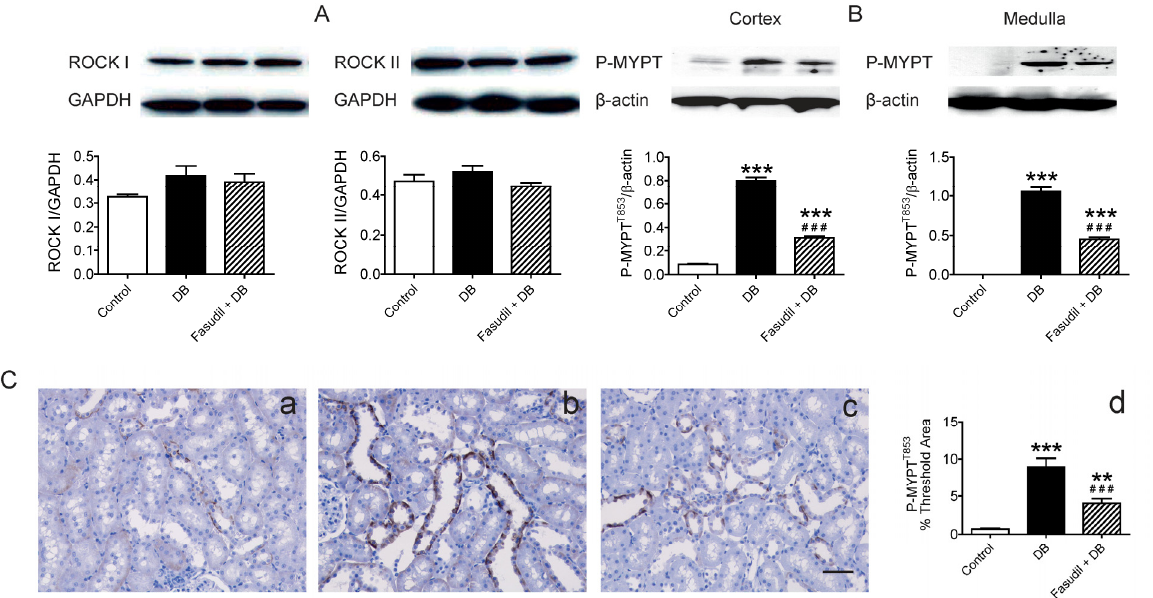
Figure 5. Effects of Rho kinase inhibition on Rho kinase expression and activity in kidney of diabetic rats. ( A ) Representative bands and analysis of protein levels of ROCK I and ROCK II in renal cortex of rats; ( B ) Representative bands and analysis of protein levels of phosphorylated form of MYPT1 (P-MYPT1) from the renal cortex and medulla; ( C ) Quantitative analysis and representative images of immunohistochemistry for P-MYPT1 from the renal cortex. a, control rats; b, diabetic rats; c, diabetic rats treated with fasudil; d, statistical analysis of immunohistochemistry for P-MYPT1 in renal cortex. ** p < 0.01, *** p < 0.001 compared with control group; ### p < 0.001 when compared diabetic rats with and without treatment of fasudil. Data are mean ± S.E.M. from five different